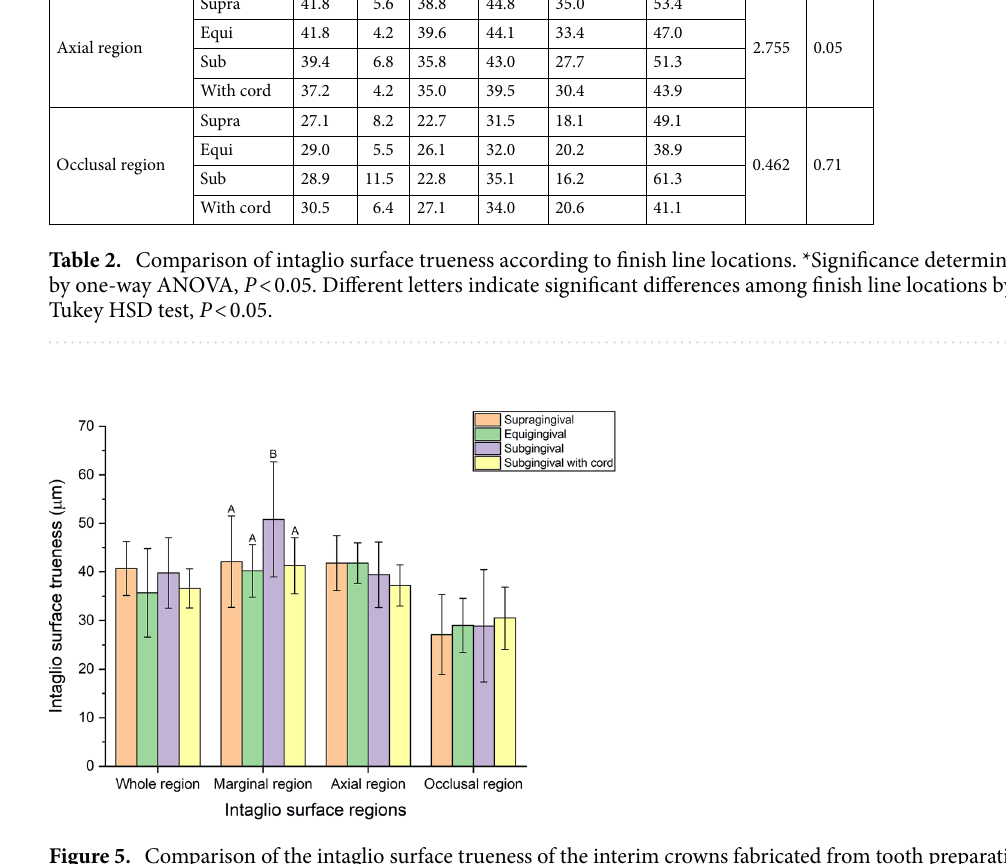
Figure 5. Comparison of the intaglio surface trueness of the interim crowns fabricated from tooth preparation scanned at four finish lines. Different letters indicate significant differences among finish line locations by Tukey HSD test, P < 0.05.